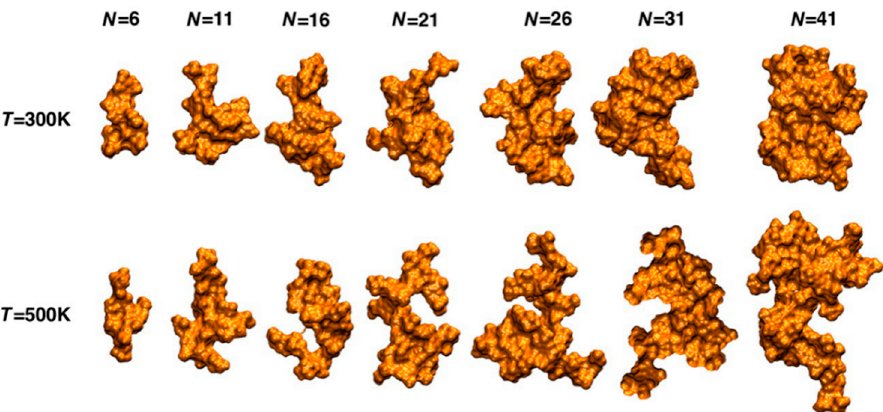
Figure 4. Representative structures of the atomistic molecular dynamics simulations of lignin in aqueous solution at degrees of polymerization between 6 and 41 at two temperatures. Reproduced with permission [13].